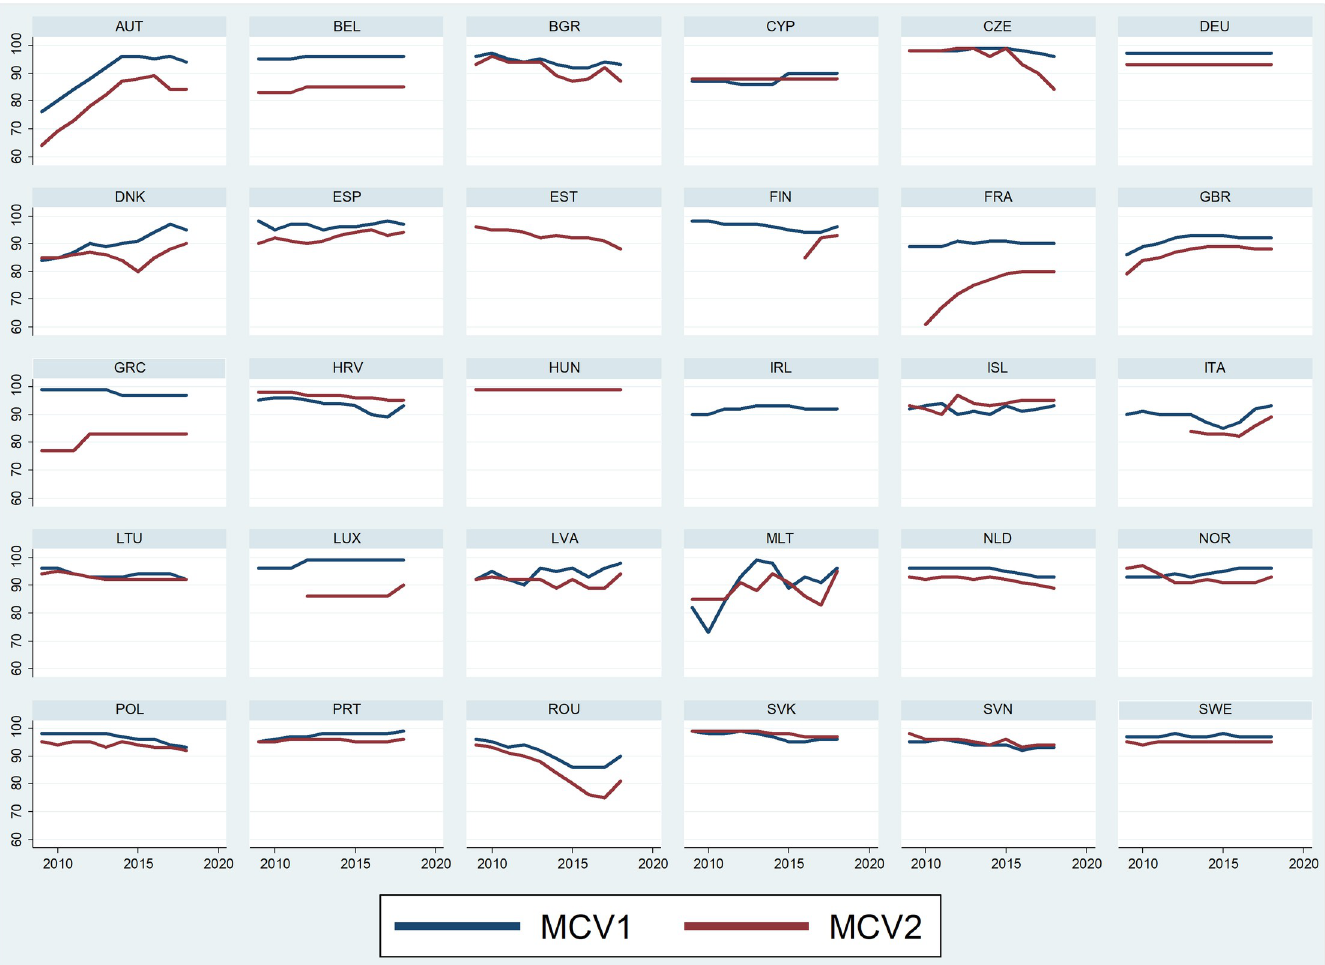
Fig 4. Vaccination coverage (%) for the first and second dose of MMR vaccine for each country in the period 2009–2018. Note that Ireland provides data only for MCV1, while no information is available for